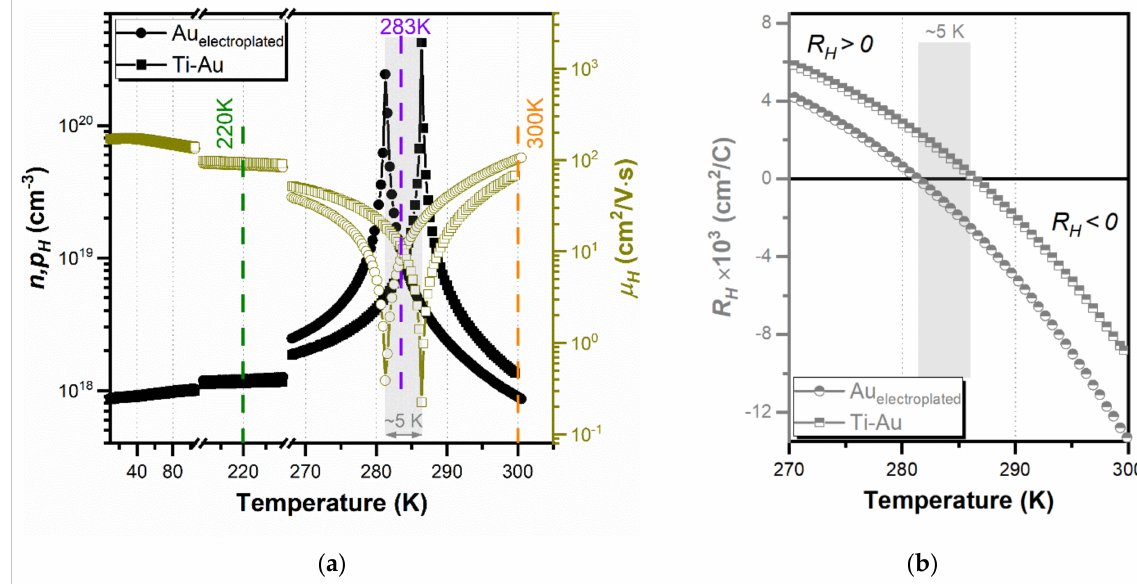
Figure 5. ( a ) Hall effect measurement results showing the temperature dependence of n,p H and µ H of both metallization types: electroplated Au and vacuum-deposited Ti–Au. The region of approximately 5 K difference in transition temperature between both metallization types is marked in grey. Additionally, magnetic-field-dependent measurements conducted at 220, 283 and 300 K are indicated. ( b ) R H as a function of temperature for both types of metallization, limited to the temperature range of 270–300 K. The change of R H sign is observed at 281 K for electroplated Au and 286 K for